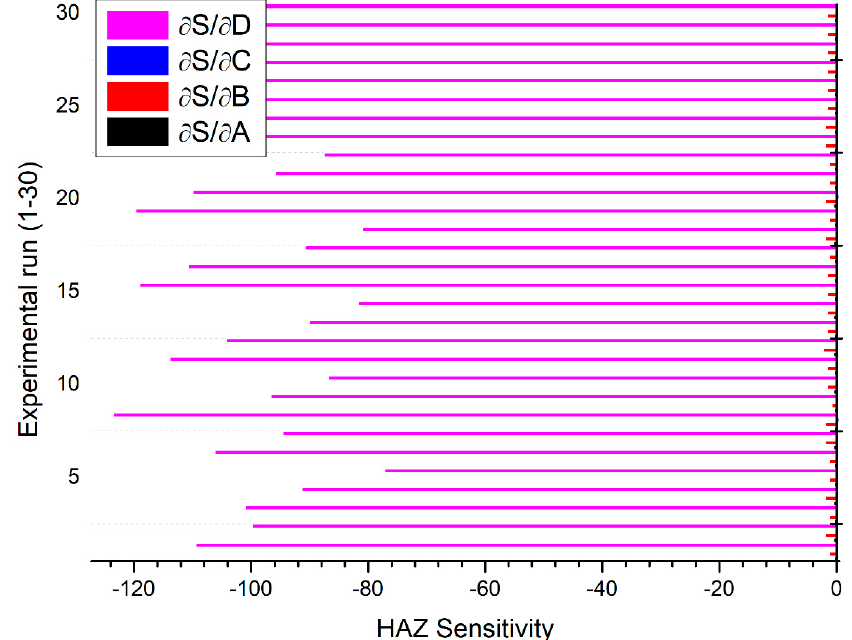
Figure 13. Sensitivity of PAC variables on HAZ.